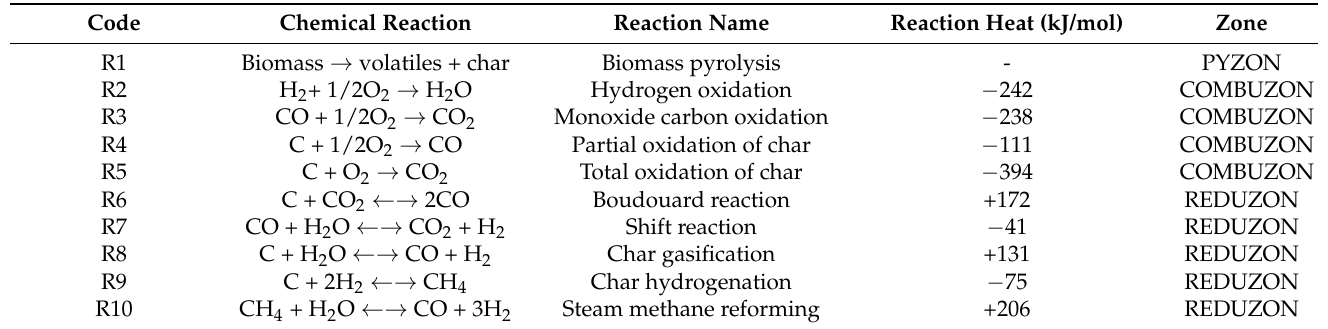
Table 2. Reactions in the gasification